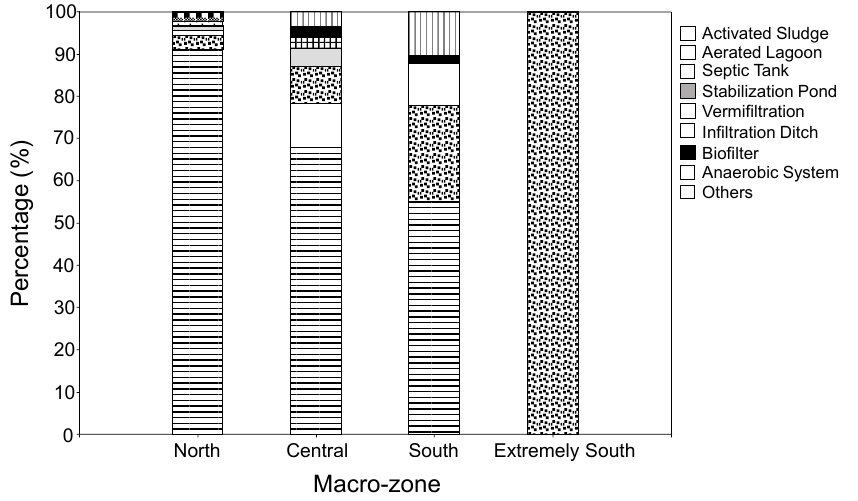
Figure 4. Rural wastewater treatment technologies applied by macrozone in Chile. North: 90 WWTP; Central: 375 WWTP; South: 49 WWTP; Extremely South: 17 WWTP. Total: 531 WWTP.